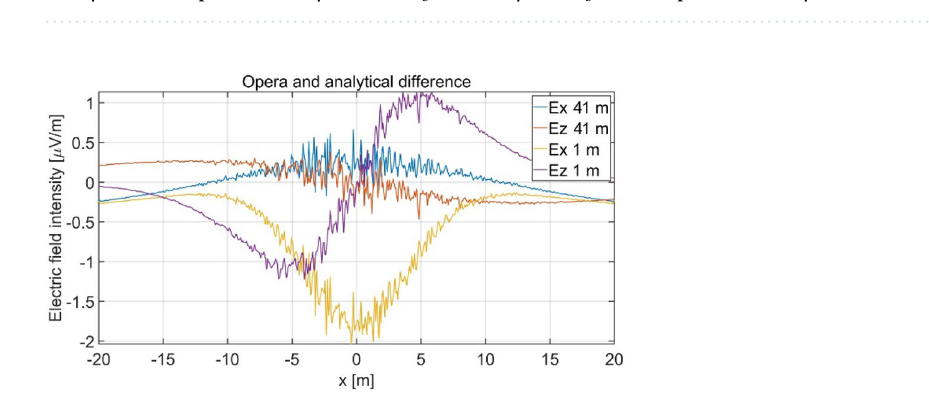
Figure 30. Distribution of E x and E z for σ w = 4 S/m, σ b = 1 S/m, a = 0.5 m, h = 1 m, h s = 7 m, h w = 9 m, h b = 1 m (analytical and Opera—four layers) and ( h b → ∝ analytical, h b = 91 m Opera—three layers).